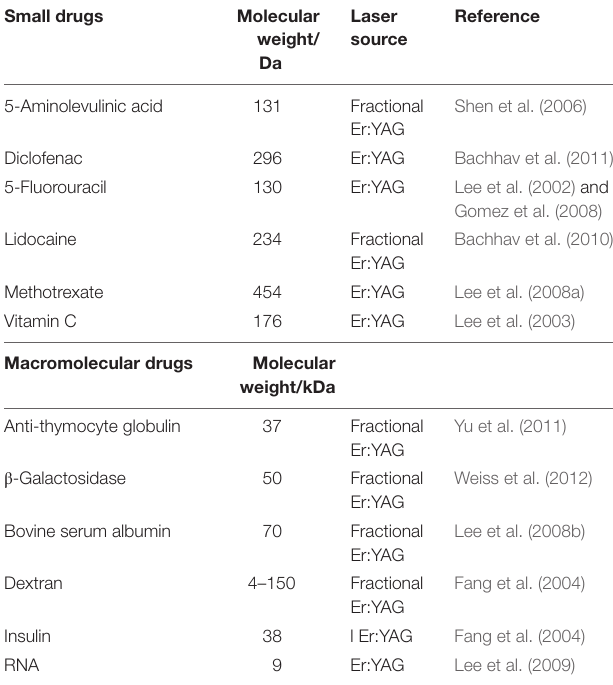
TAble 3 | Drugs transdermally delivered using laser ablation